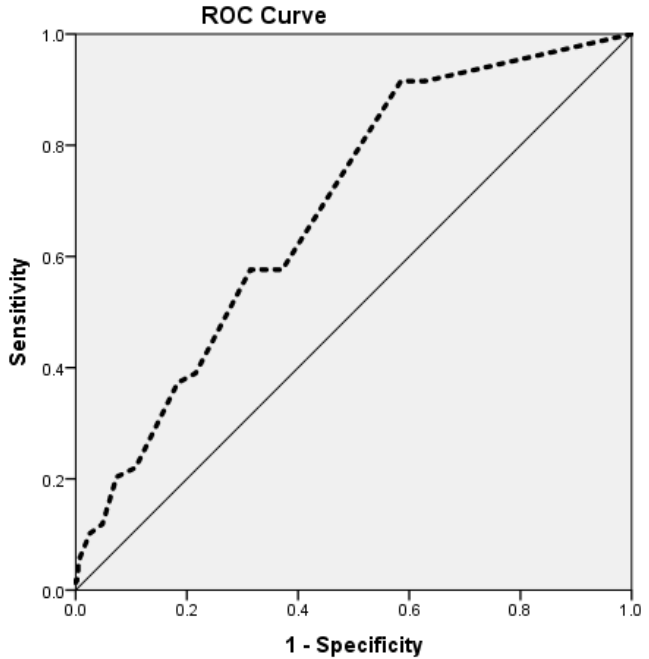
Figure 1. Receiver operating characteristic (ROC) analysis of the PACV scores for the screening of vaccine hesitancy.